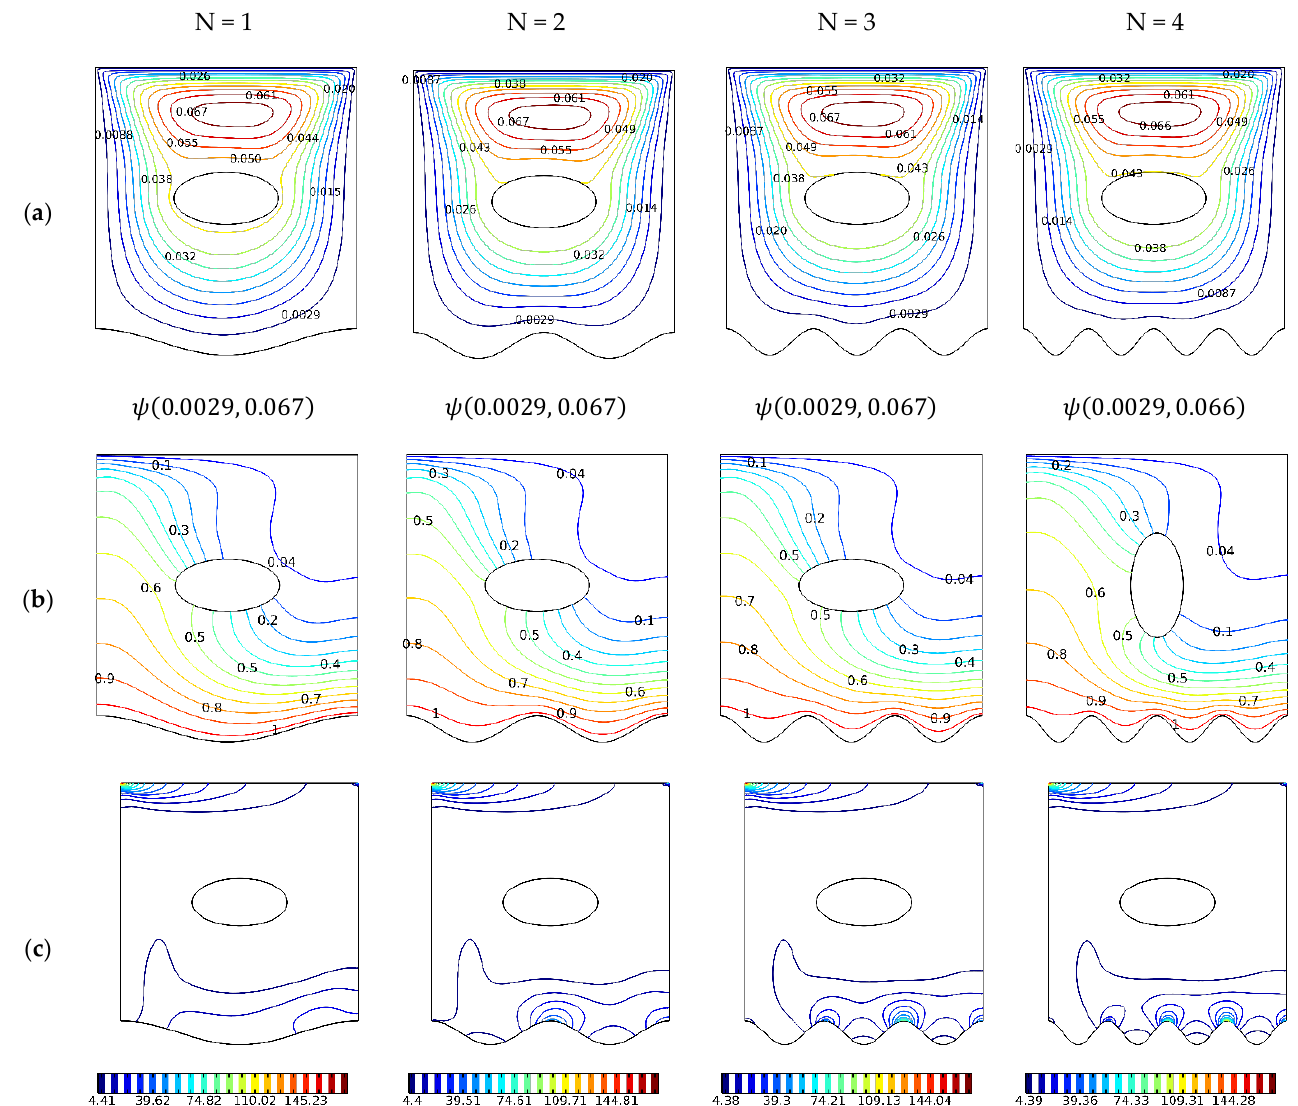
Figure 6. Streamlines, Isotherms, and Isentropic contours, γ : 0 ◦ ; N = 1, 2, 3,4; Ha = 0; Ri = 1; ϕ = 0.02. ( a ) ψ ; ( b ) Θ ; ( c ) S.